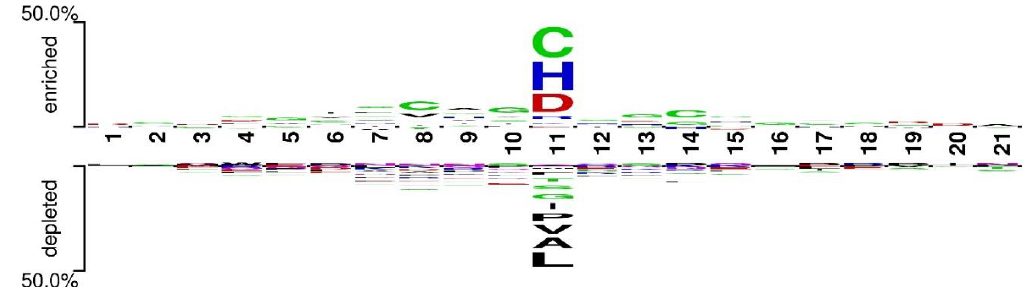
Figure 2. Two-sample logos of universal ligand-binding residues against non-binding residues.